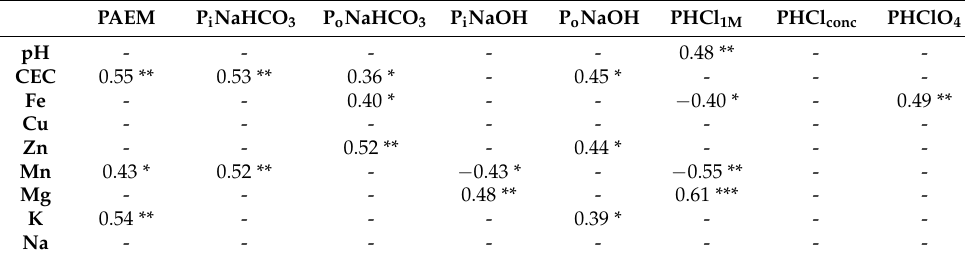
Table 6. Spearman’s correlations between P fractions and soil chemical fertility-related parameters